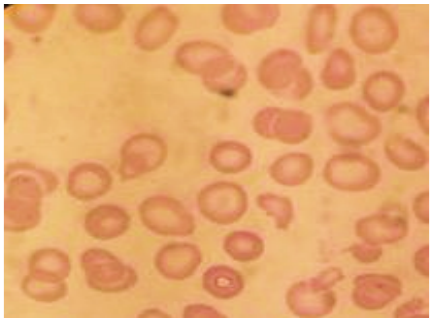
Figure 1: Peripheral blood smear.